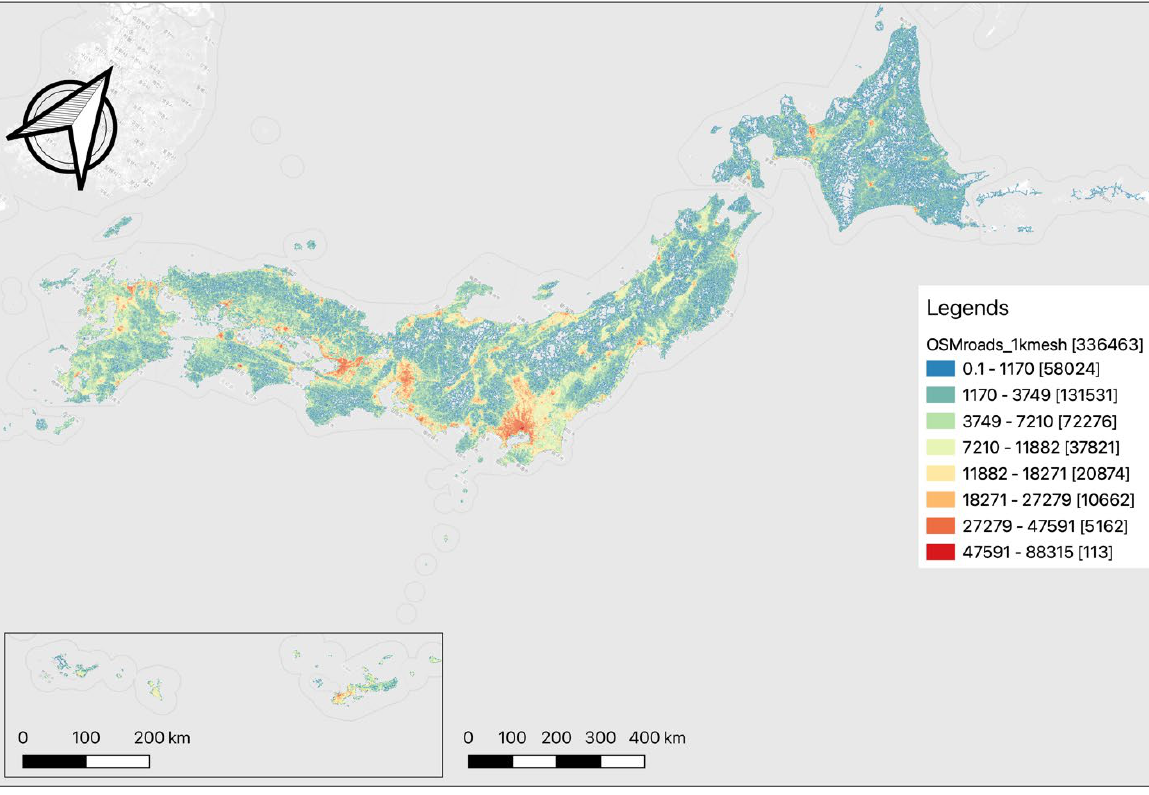
Figure 5. OpenStreetMap road extension in 1-km meshes (unit: